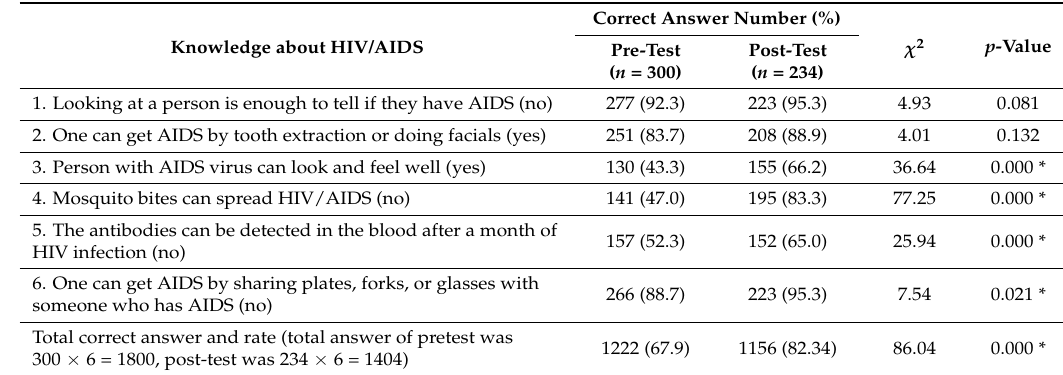
Table 4. Intervention effect on HIV/AIDS knowledge.